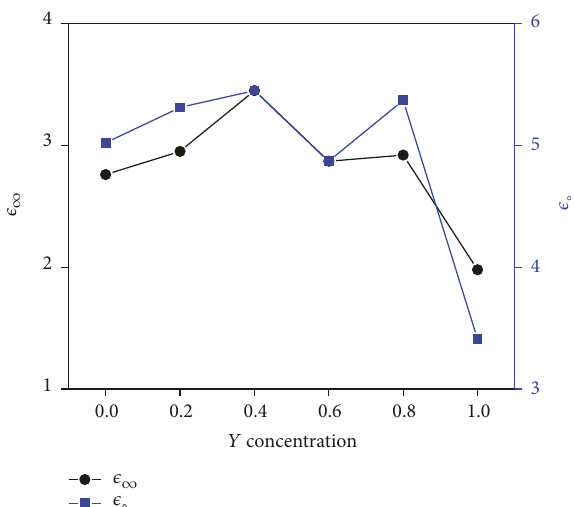
Figure 6: The high frequency dielectric constant, 𝜖 ∞ (closed circle), and static dielectric constant, 𝜖 ∘ (closed square), as a function of concentration 𝑥 .